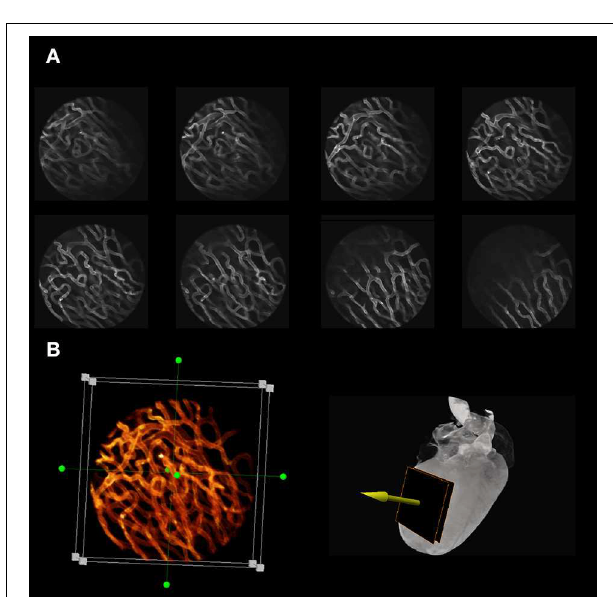
FIGURE 12 | Optical sectioning of cardiac microvasculature stained with lectin, obtained in vivo in the beating heart, after motion artifacts removal. (A) Sequence of images taken at different depths in 5- µ m increments using a × 20 MicroProbe objective. In-frame motion artifacts present within the raw images are removed and motion-free images are reconstructed using a retrospective gating scheme and sequential segmented microscopy (SSM). (B) Optical sectioning along the indicated direction (yellow arrow) allows for three-dimensional reconstructions of the beating heart in vivo